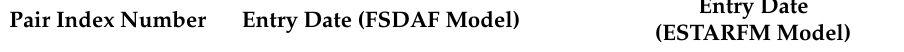
Table 1. Different input image pairs used for spatio-temporal fusion for the first and the second study